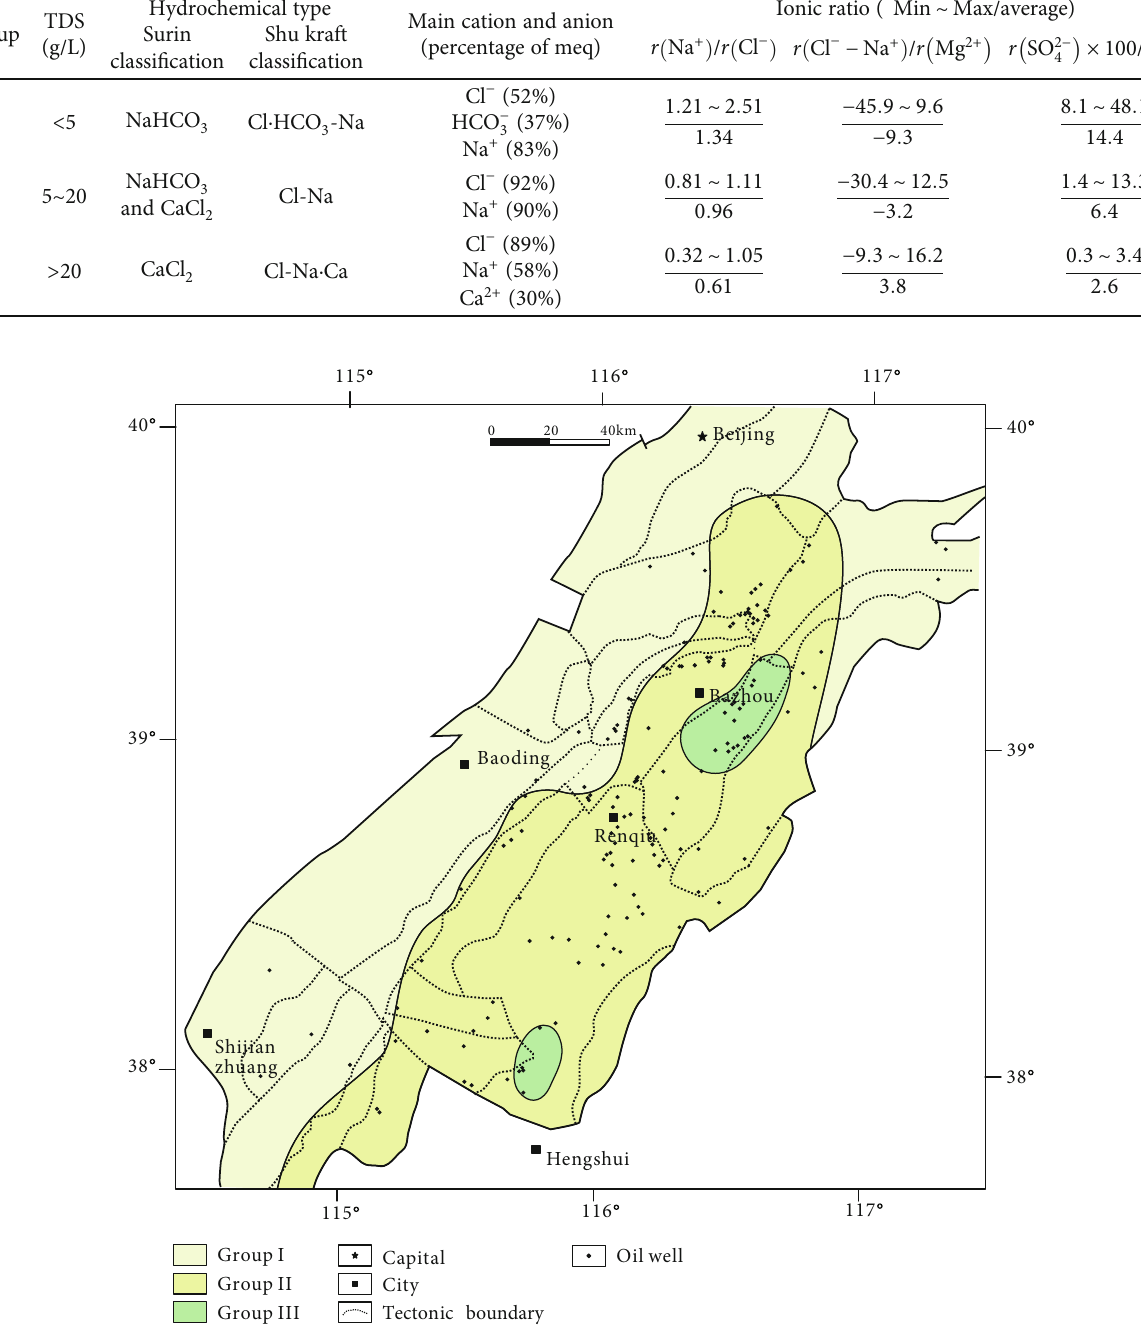
Table 2: Geochemical characteristics of geothermal water in the buried hill of the study area.